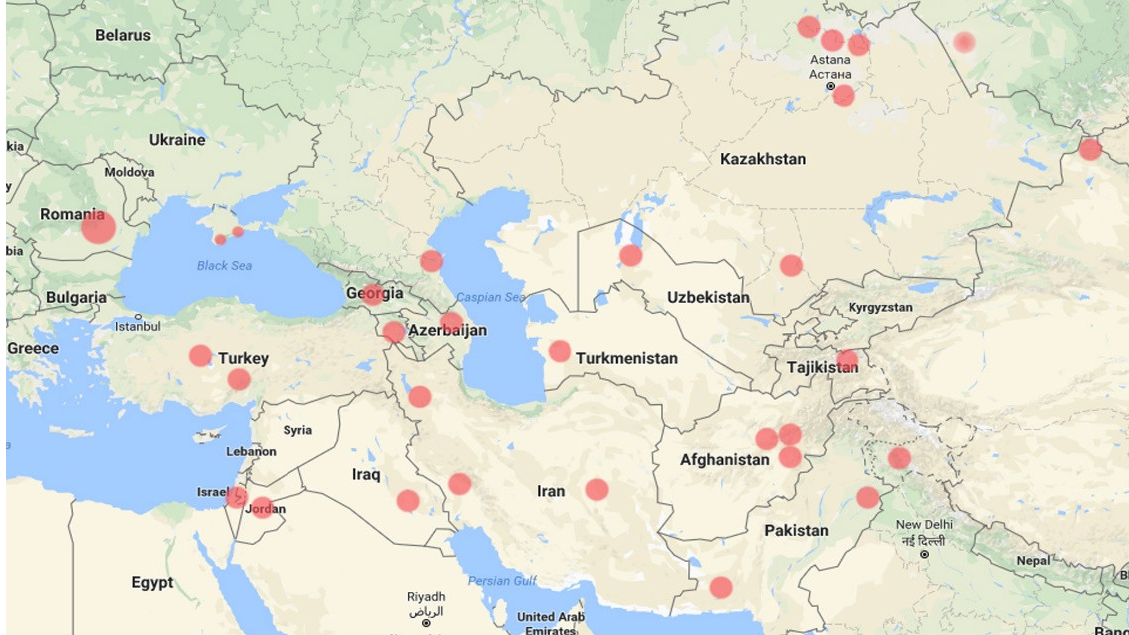
Figure 1. General distribution of N. schoberi —dots indicate locations of documented (Floras or herbarium specimens) populations.